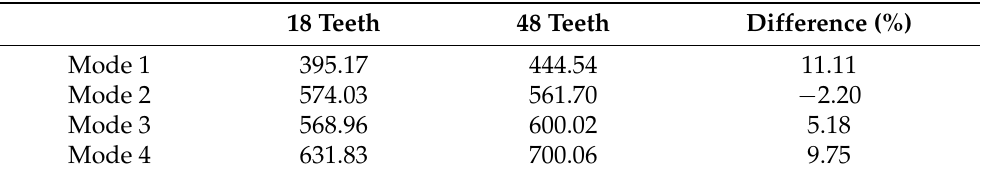
Table 4. Comparison of the first four natural frequencies (in Hz) of the stators with different numbers of